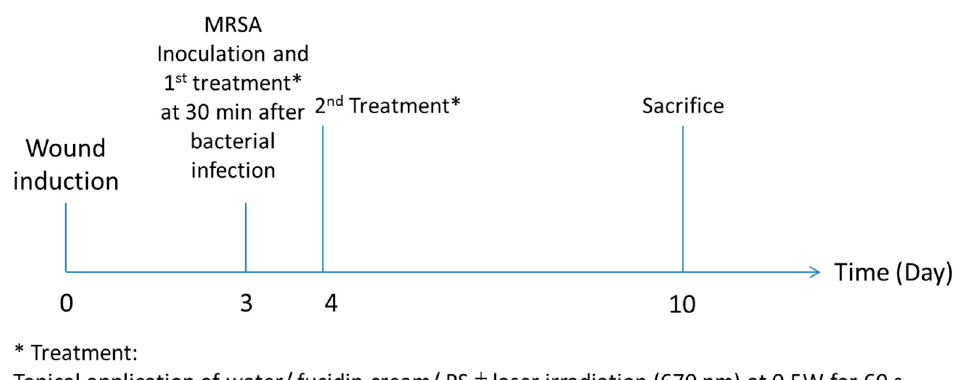
Figure 3. Timeline for the topical treatment